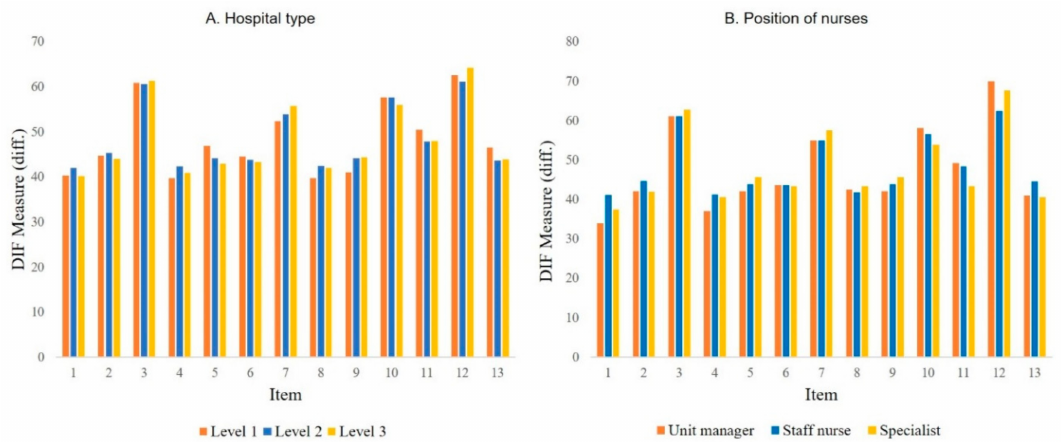
Figure 2. Di ff erential item functioning of the Korean version of the CS-PAM according to hospital type and nurse position. ( A ). Hospital type: item 5 was easier for level 3 than for level 1. ( B ). Nurse position: Unit managers found it easier to answer item 1 than did sta ff nurses. Sta ff nurses found it easier to answer item 12 than did the unit managers and specialists. Hospital type. Level 1 = hospital, Level 2 = general hospital, Level 3 = tertiary